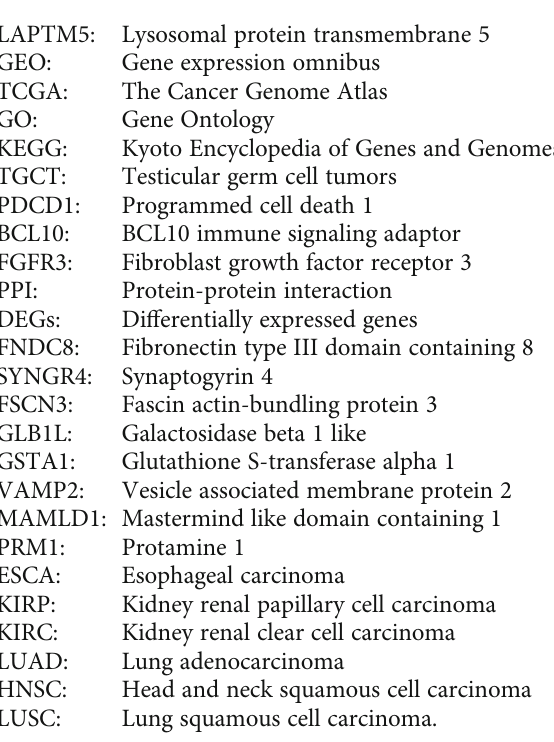
Table S1: the detailed information on Venn diagrams related to upregulated DEGs. Table S2: the detailed information on Venn diagrams related to downregulated DEGs. Table S3: the detailed statistical information related to GO analysis. Table S4: the detailed statistical information related to REACTOME analysis. Table S5: the detailed statistical infor- mation related to PANTHER analysis. Table S6: the detailed statistical information related to KEGG analysis. Table S7: the detailed information about the Venn diagram between OS-related genes and DEGs. Table S8: the detailed informa- tion about the Venn diagram between OS-related genes and Top 40 hub genes. (Supplementary